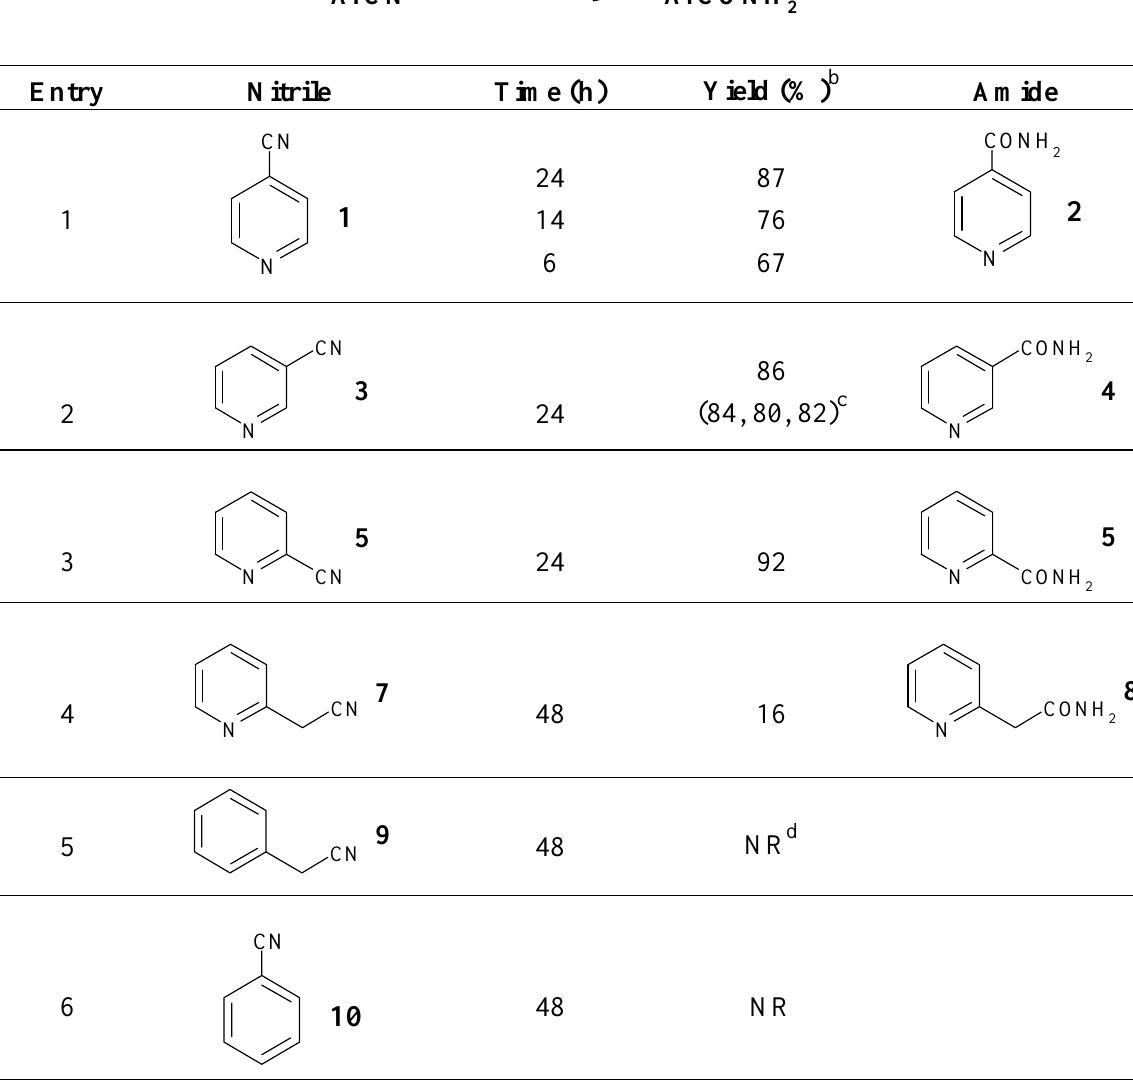
Table 1. Hydrolysis of nitriles into amides a